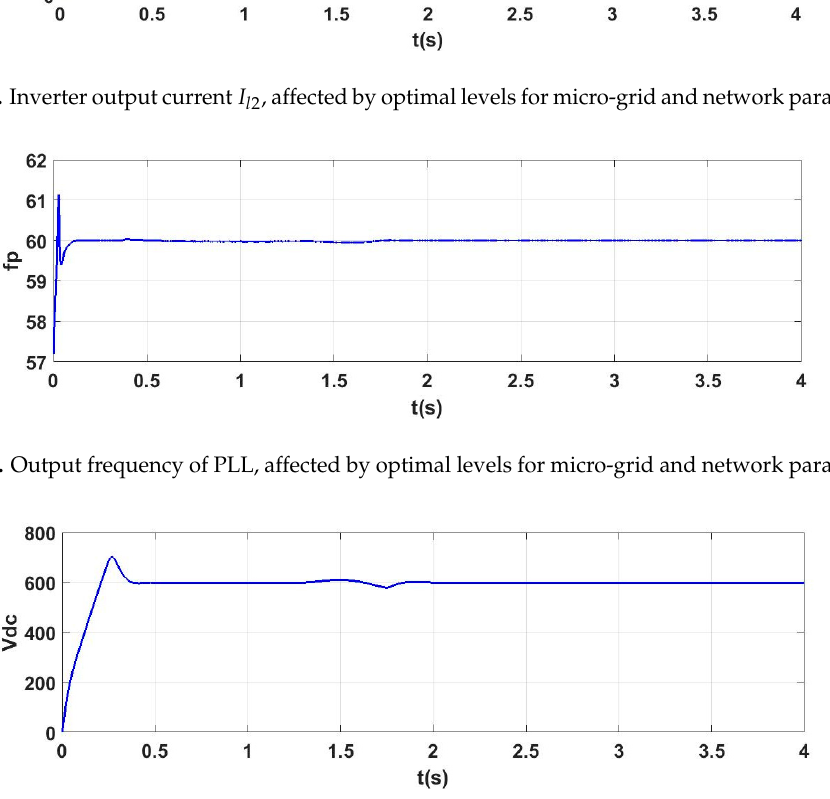
Figure 12. DC bus voltage, affected by optimal levels for micro-grid and network parameters.